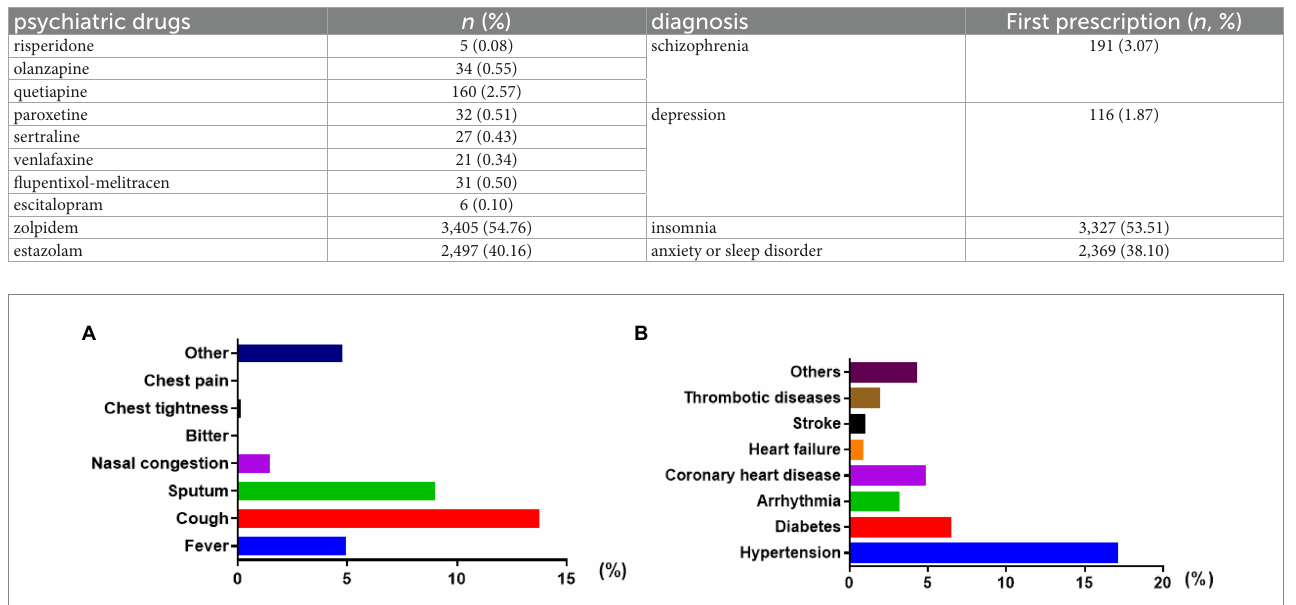
FIGURE 1 General characteristics of physical symptoms and distribution of comorbidities in infected patients treated with associated psychiatric drugs. (A) proportion of COVID-19 symptoms. (B) proportion of